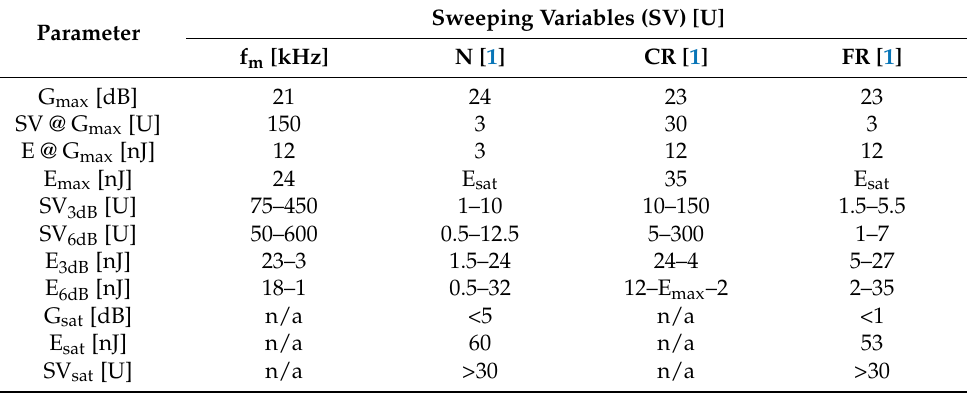
Table 2. Summary of dMUT gains and energy optimization parameters and their